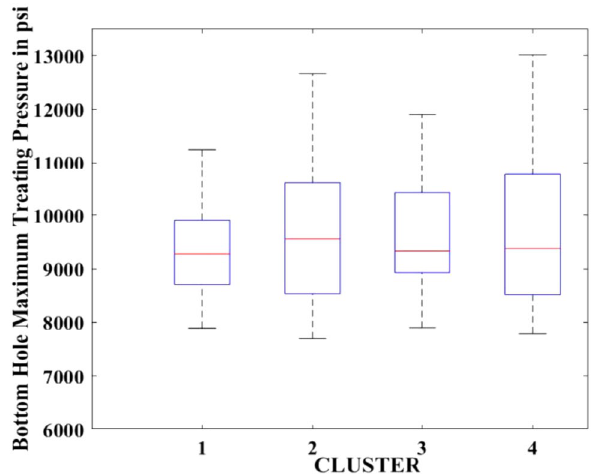
Figure 17. Bottom hole maximum treating pressure.